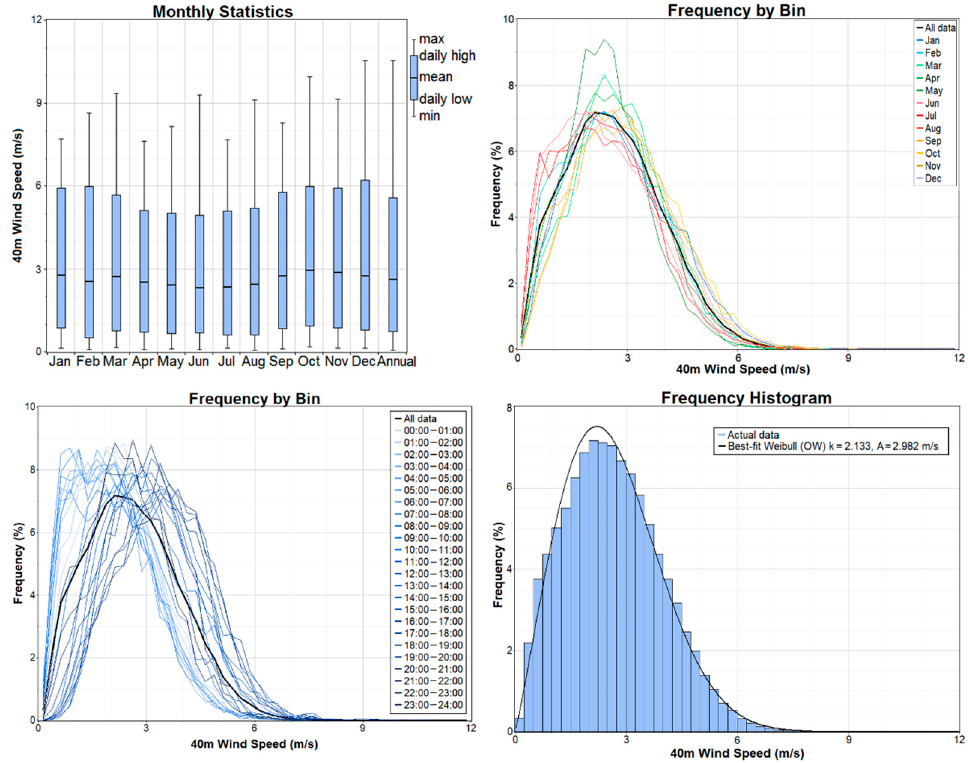
Figure 9. Statistics of the three year wind speed measured by the Lidar sensor. Source: Our elaboration using Windographer ® . Table 2. Summary of LIDAR wind measurements (233 m far from the wind turbine location).